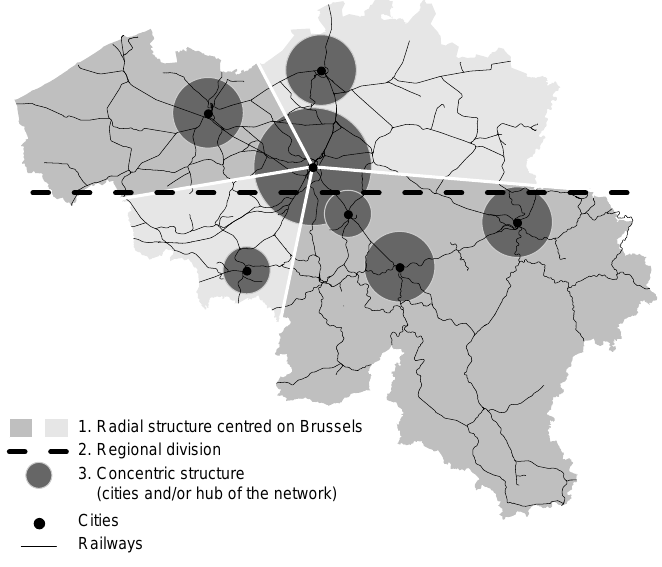
Figure 9. Chorematic representation of the travel demand by train in